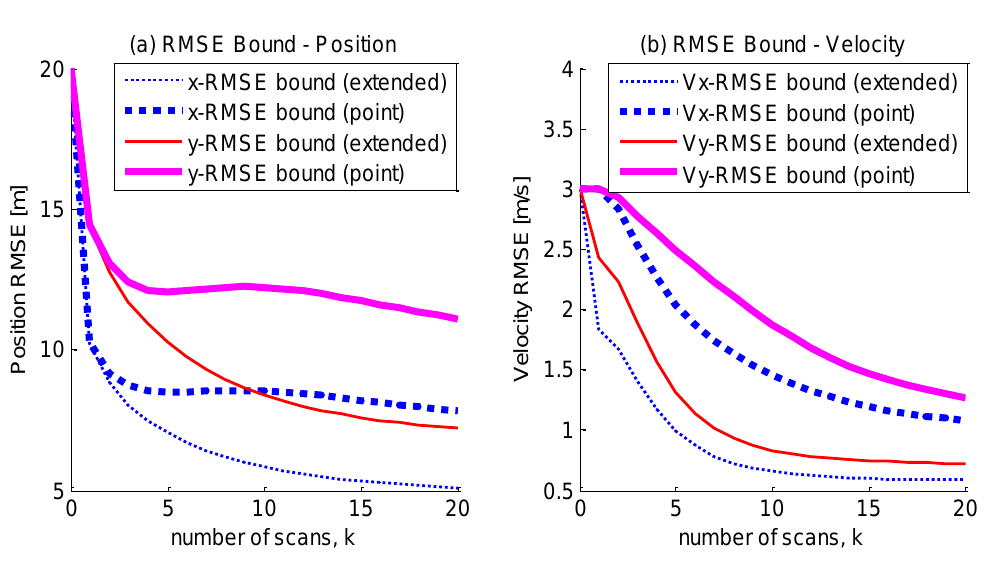
Figure 2. The comparison of the PCRLB curves of the extended and point target models for (a) the target position in the directions of the x and y axes and (b) the target velocity in the directions of the x and y axes.